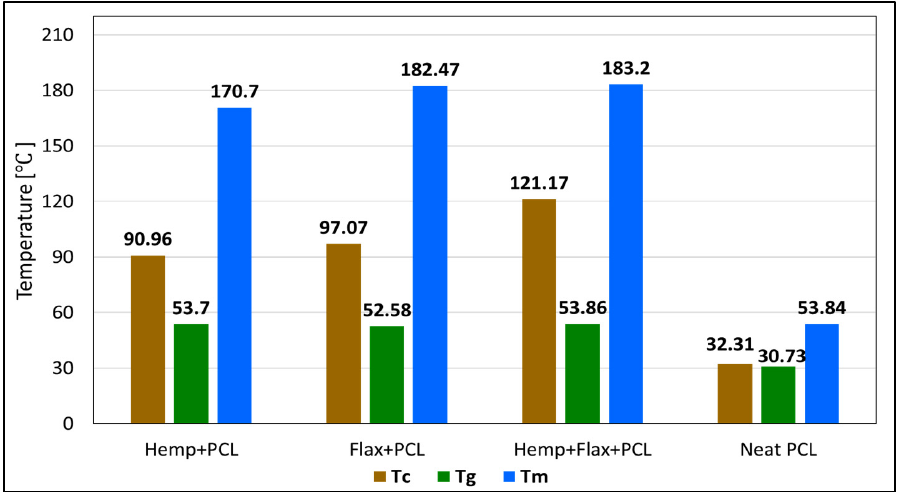
Figure 11. Comparison of DSC results of different samples.